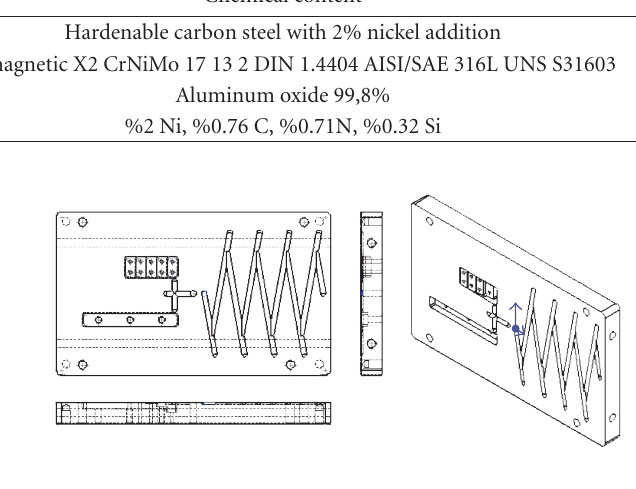
Figure 5: Zigzag-shaped yield length measurement